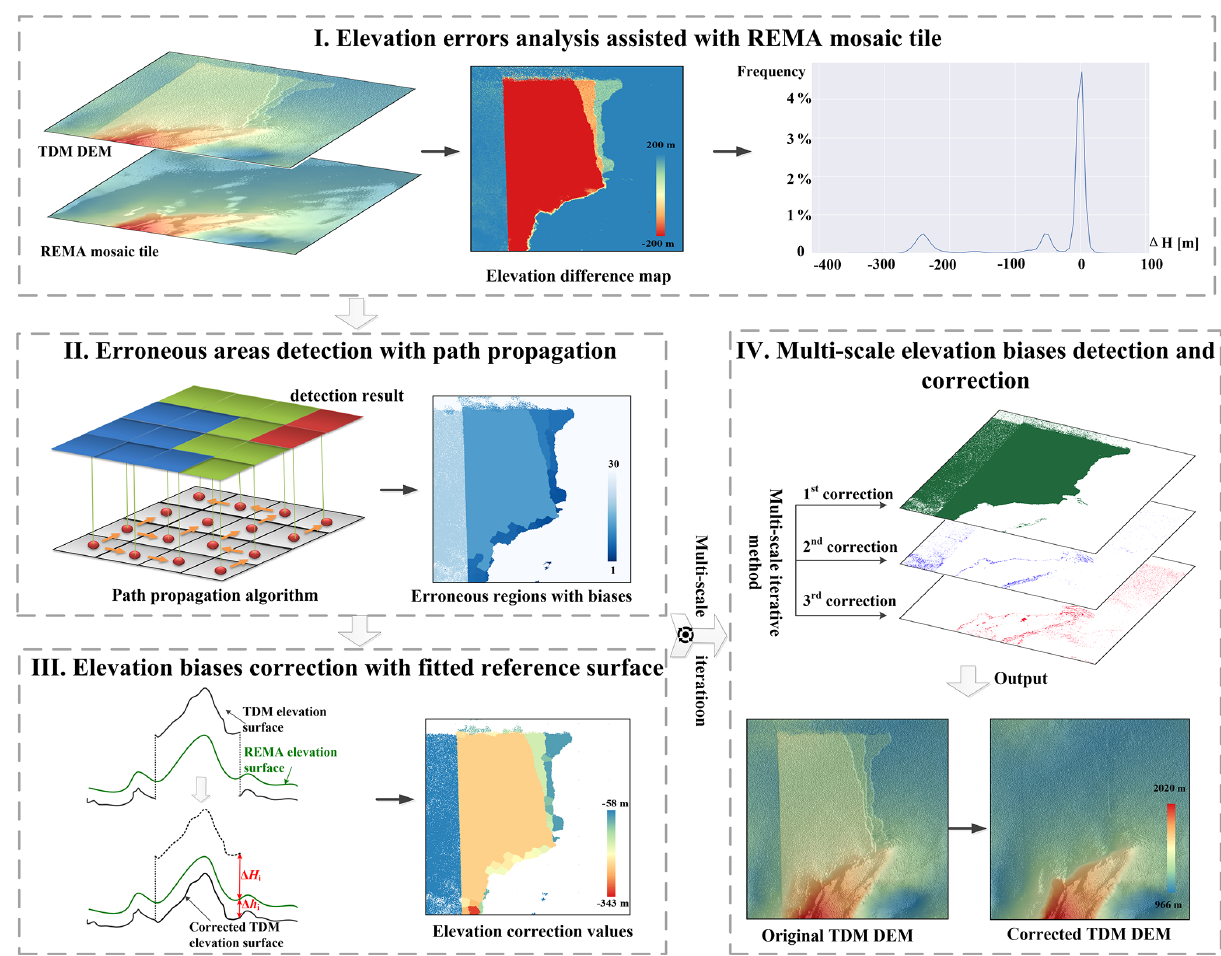
Figure 2. The framework of TDM DEM correction with REMA mosaic tiles organized in modules I to IV.